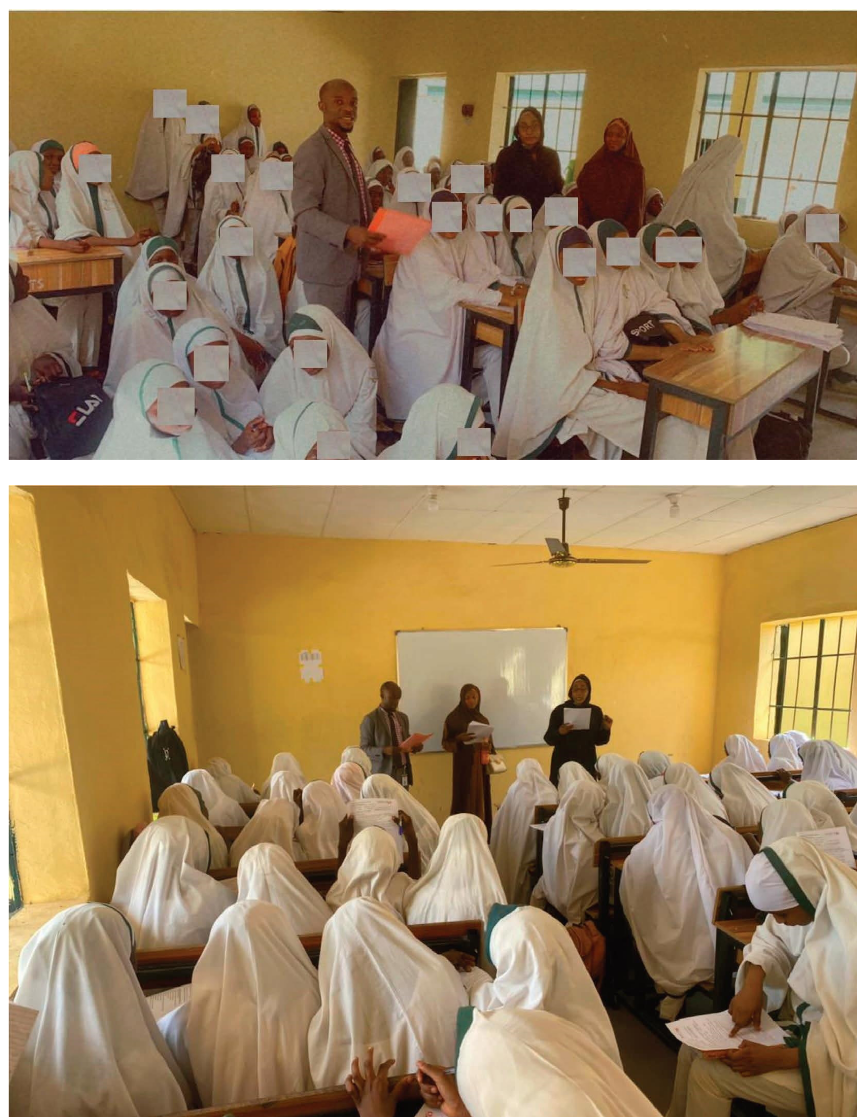
Figure 2: Sensitization on the health efect of HPV and cervical cancer conducted at Professor Hafsat Abdullahi Ganduje Secondary School Gyadi-Gyadi, Kano State,